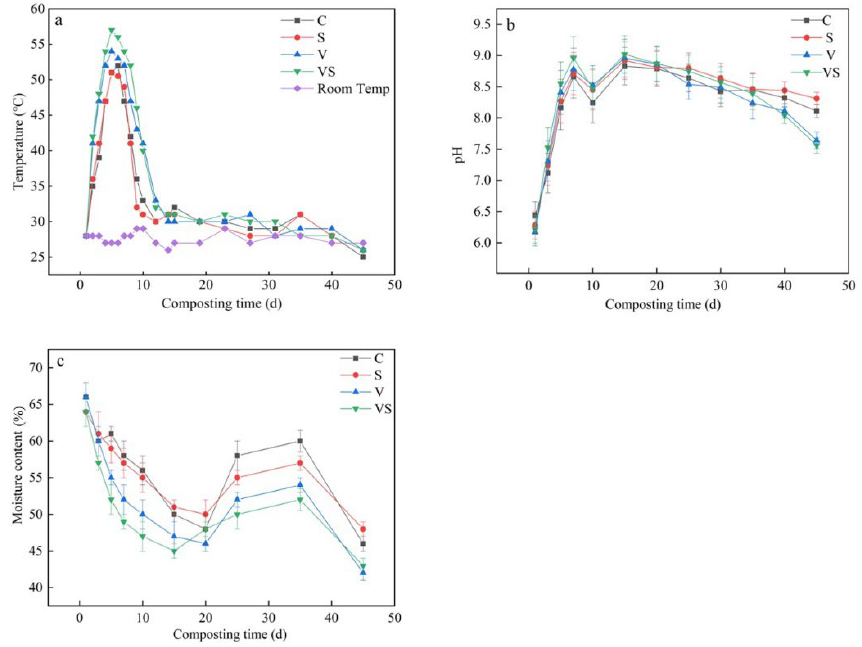
Figure 1. Changes in physicochemical properties during composting of different experiment groups (control (C), ventilation (V), coral sand (S), ventilation and coral sand (VS)): pile temperature and ambient temperature ( a ), pH ( b ), and moisture content ( c ).